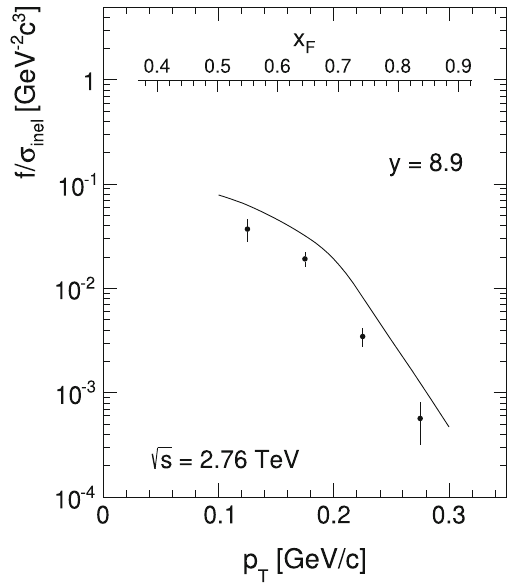
Fig. 94 Invariant π 0 cross sections f /σ inel as a function of p T for √ s = 2.76 TeV (data points from LHCf) compared to rapidity 8.9 at √ s = 63 GeV (full predicted π 0 yields at